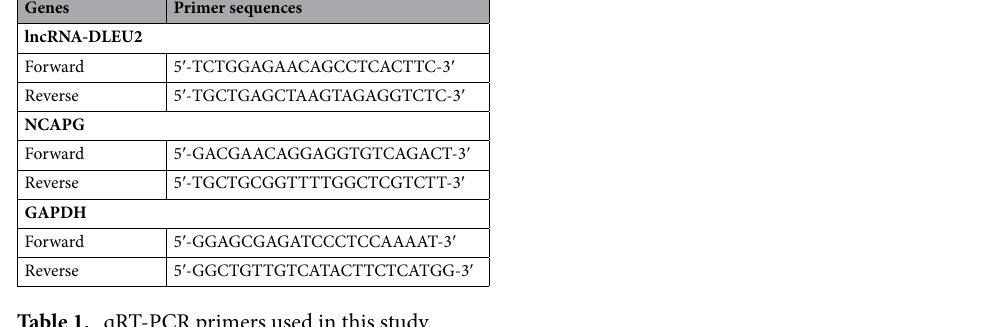
Table 1. qRT-PCR primers used in this